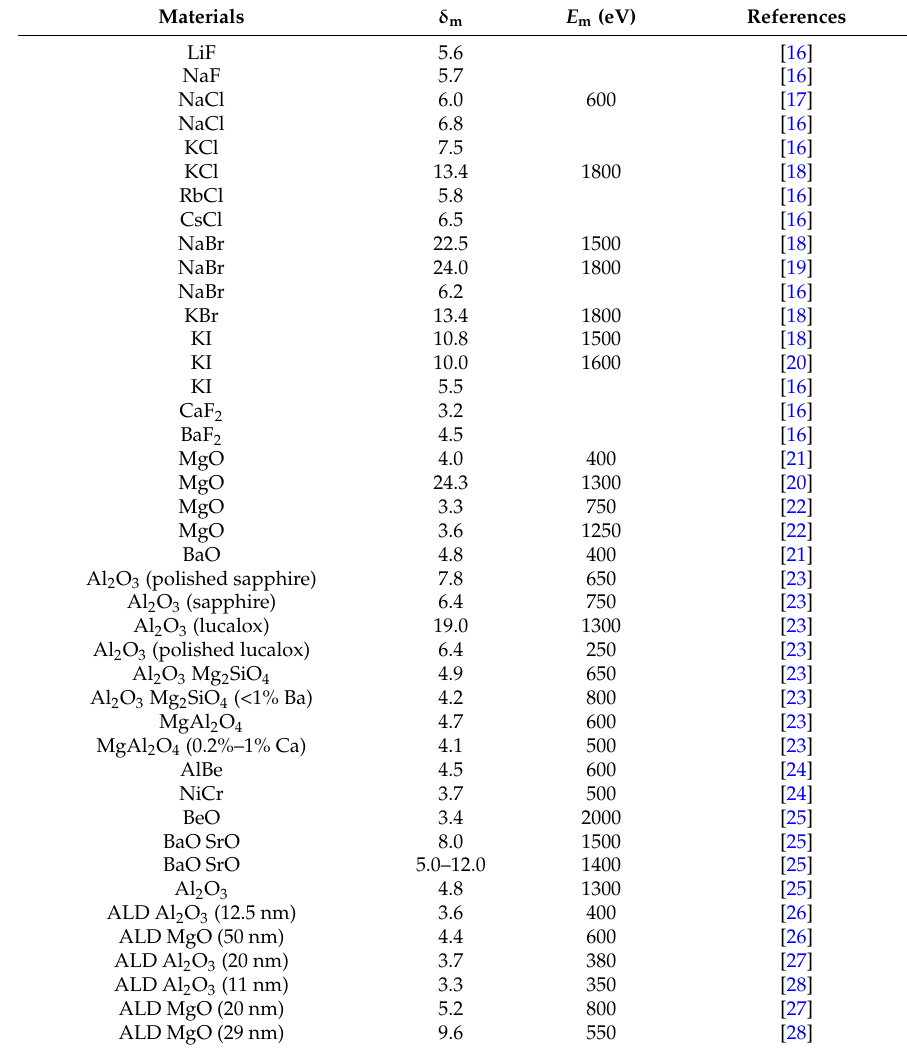
Table 1. Materials with RSEY (Figure 2) greater than 3. δ m is the maximum SEY found in the SEY as a function of primary energy curve (Figure 4). E m is the primary energy (in eV) where the maximum SEY was